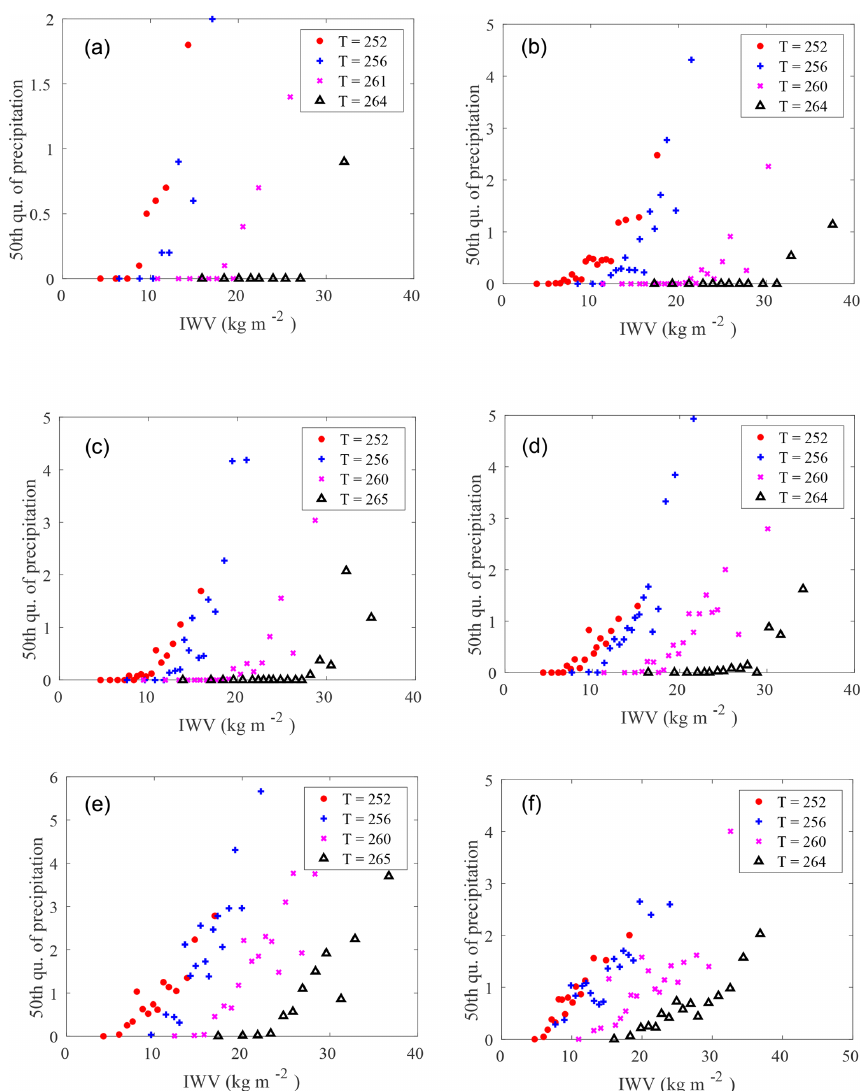
Figure 7. The 50th quantile of precipitation as a function of IWV for four different bins of tropospheric temperature at 48.7 ◦ N, 2.2 ◦ E (SIRTA). (a) SIRTA-ReOBS observations. (b) CMCC50. (c) IPSL50. (d) LMD50. (e) CNRM50. (f) UCLM50. Observations are analyzed for the period 2008–2015, and models for the period 2001–2008. The values of T indicated in the legends correspond to the mean values in the bins that have been chosen as indicated in the